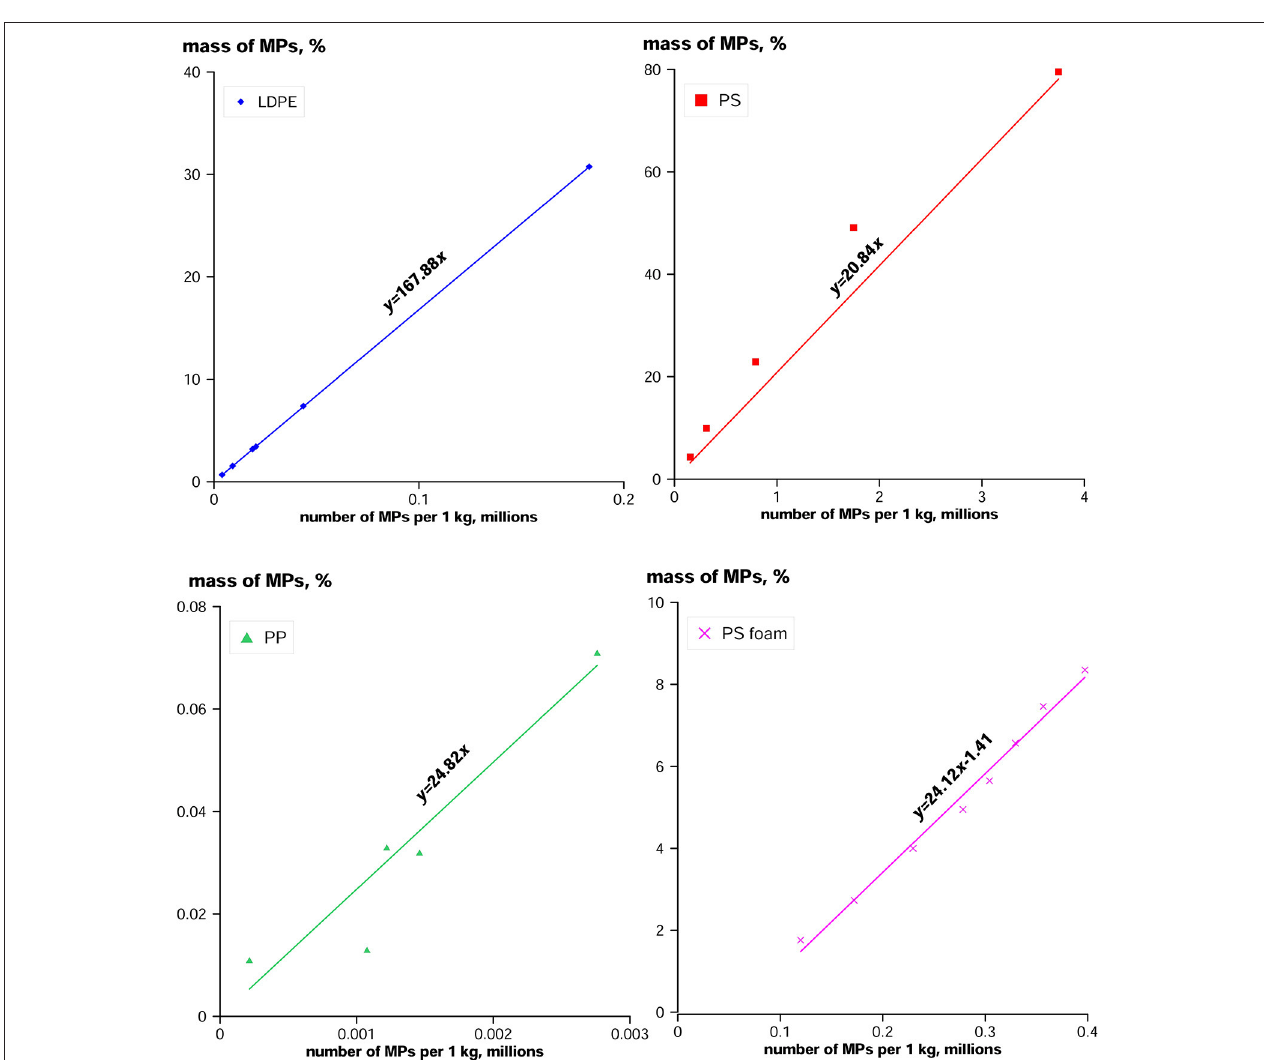
FIGURE 7 | Correlation of the fraction of mass converted to MPs and the number of MPs particles generated from 1kg of LPIs of LDPE, PS, and PP (for solid PS, data for 21 and 24h are not included due to possibly too small remaining amount of LPIs available for fragmentation).